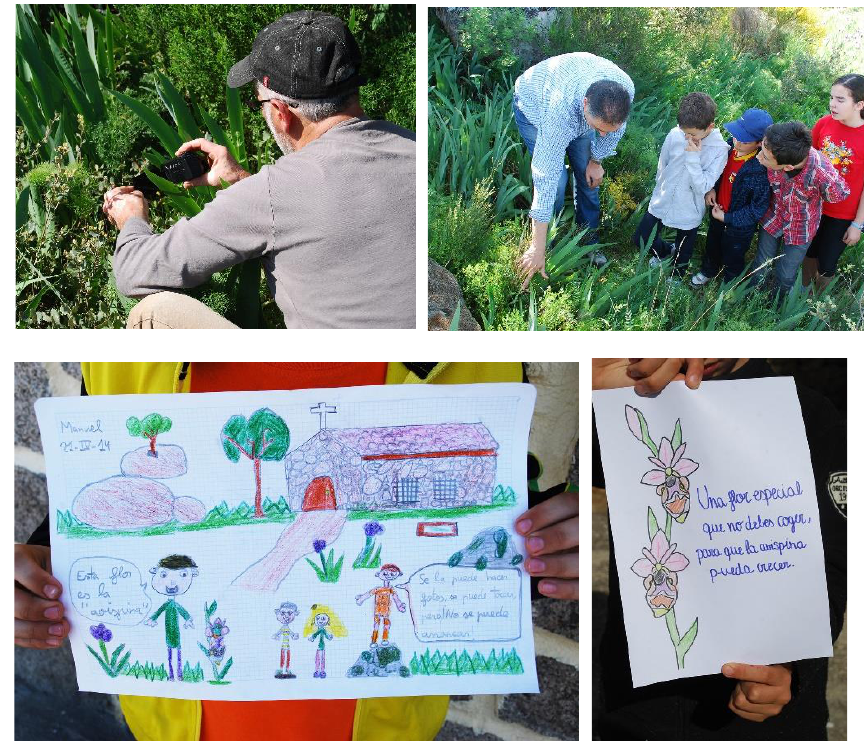
Figure 7. Different images of the educational activities implemented (photos by J.A. González).